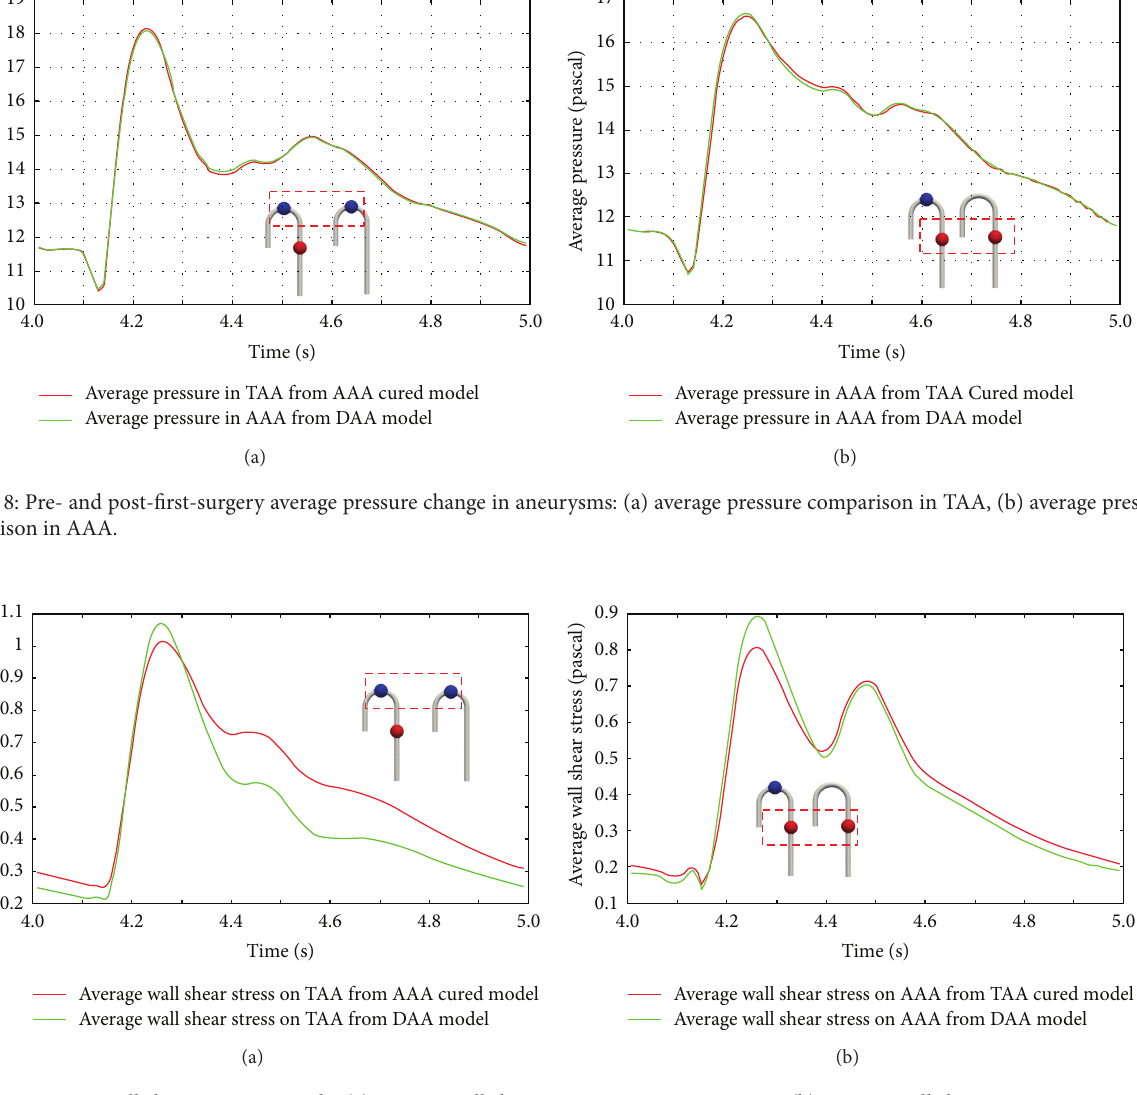
green line represents the average wall shear stress taken from